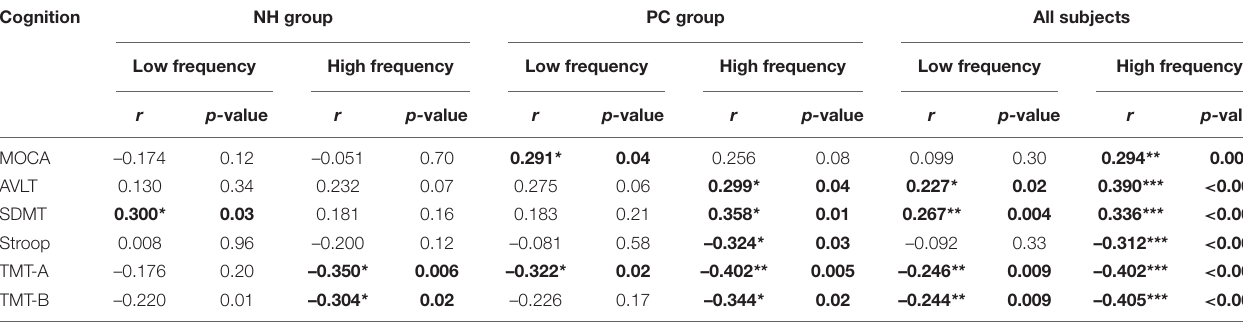
Asterisk values in bold indicate a statistically significant difference with a p-value < 0.05. *p < 0.05, **p < 0.01, and ***p < 0.001.